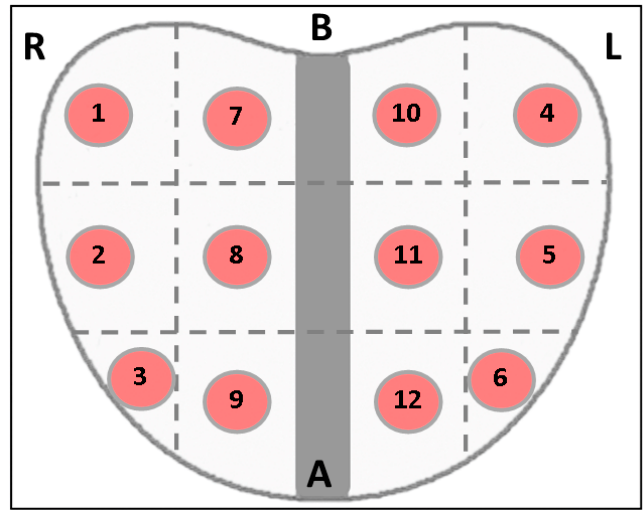
Figure 1. Prostate divided into twelve target zones, resulting a total of twelve biopsy fragments at approximatively 1 cm distance between each other. Every target zone and tissue fragment corresponds to a region evaluated with SWE measurements before the biopsies were taken (R = right, L = left, B = base and A = apex).